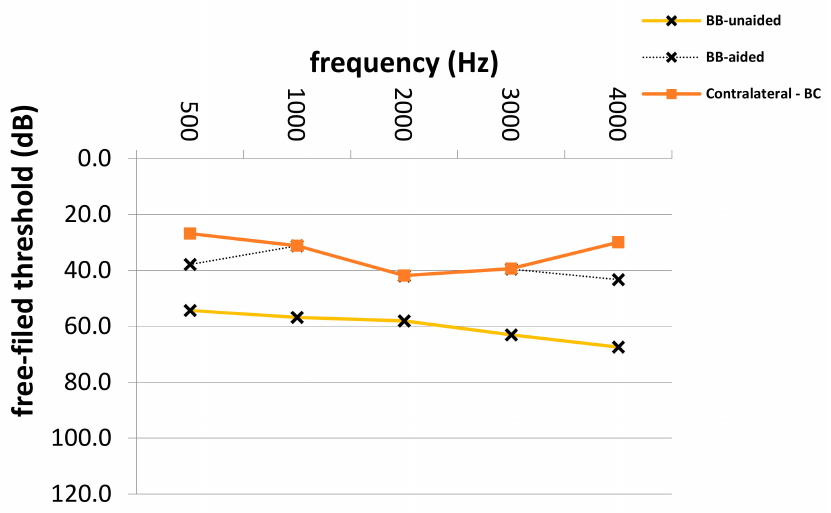
Figure 3. Aided and unaided free-field thresholds in patients with SSD. SSD; single-side